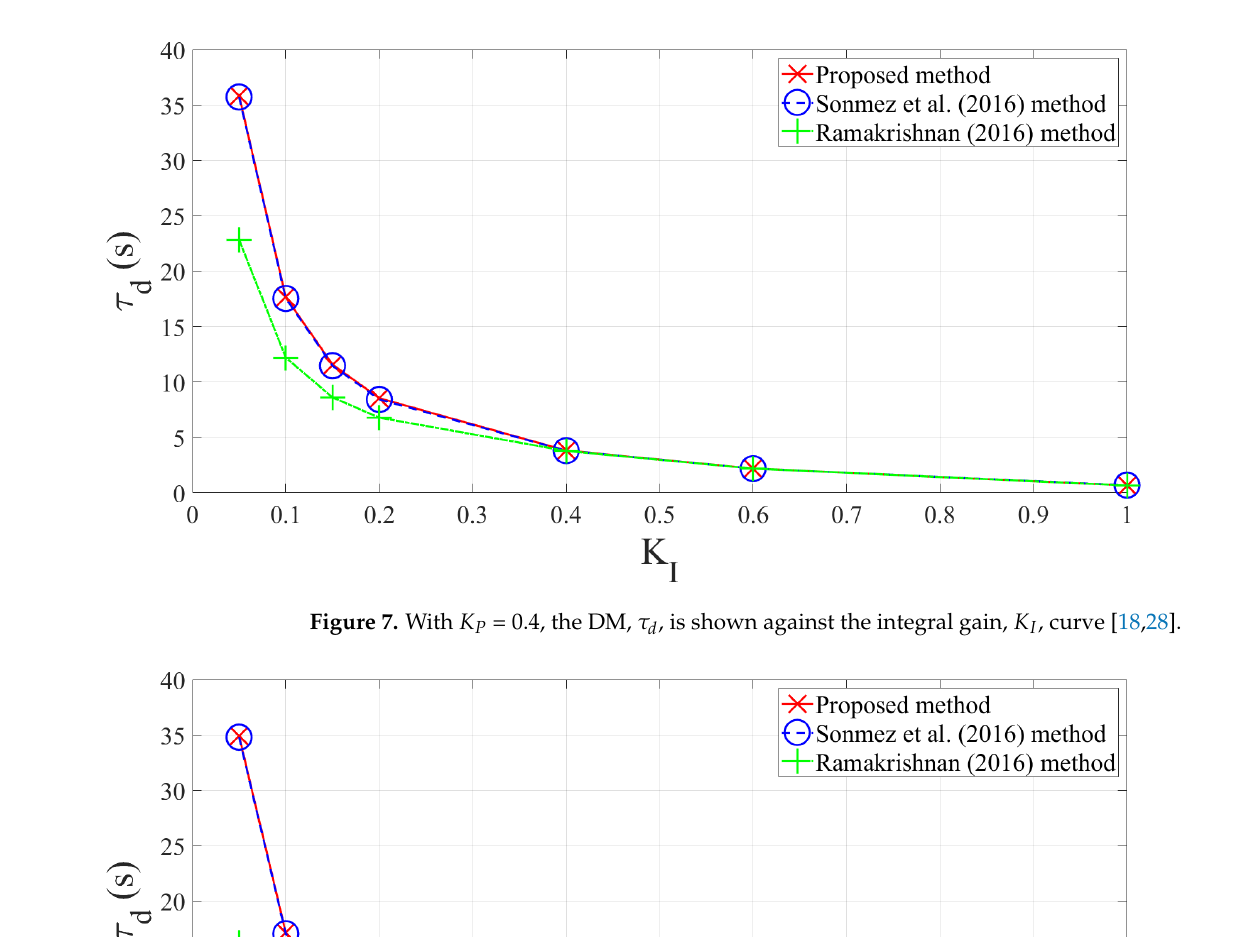
Figure 8. With K P = 0.6, the DM, τ d , is shown against the integral gain, K I , curve